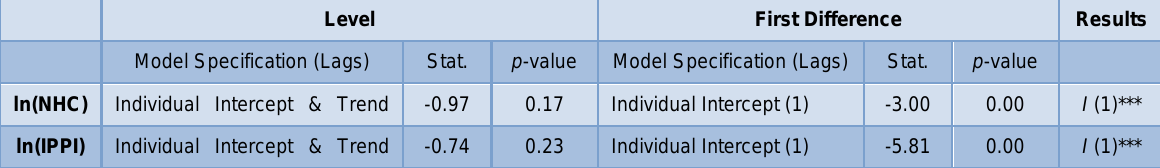
Table 1 Summary of the IPS unit root test results